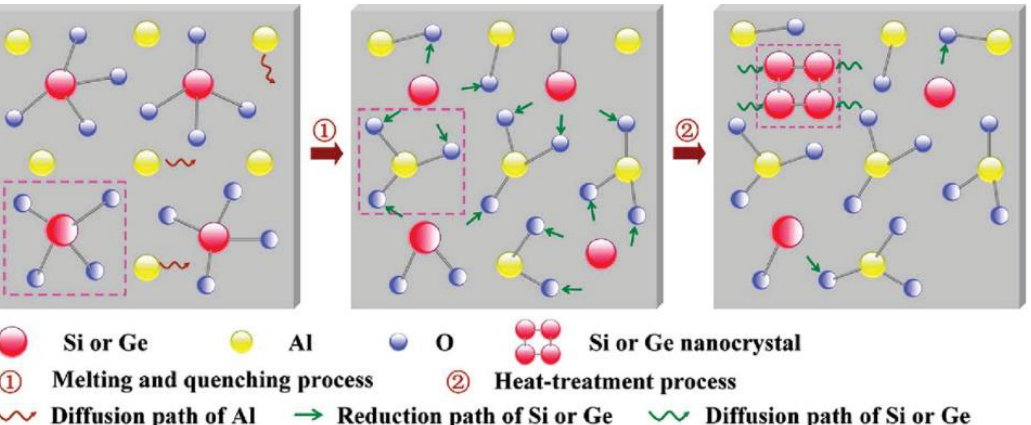
Figure 10. Schematic illustrations of the local transitions inside the glass composite. Reprinted with permission from Ref.